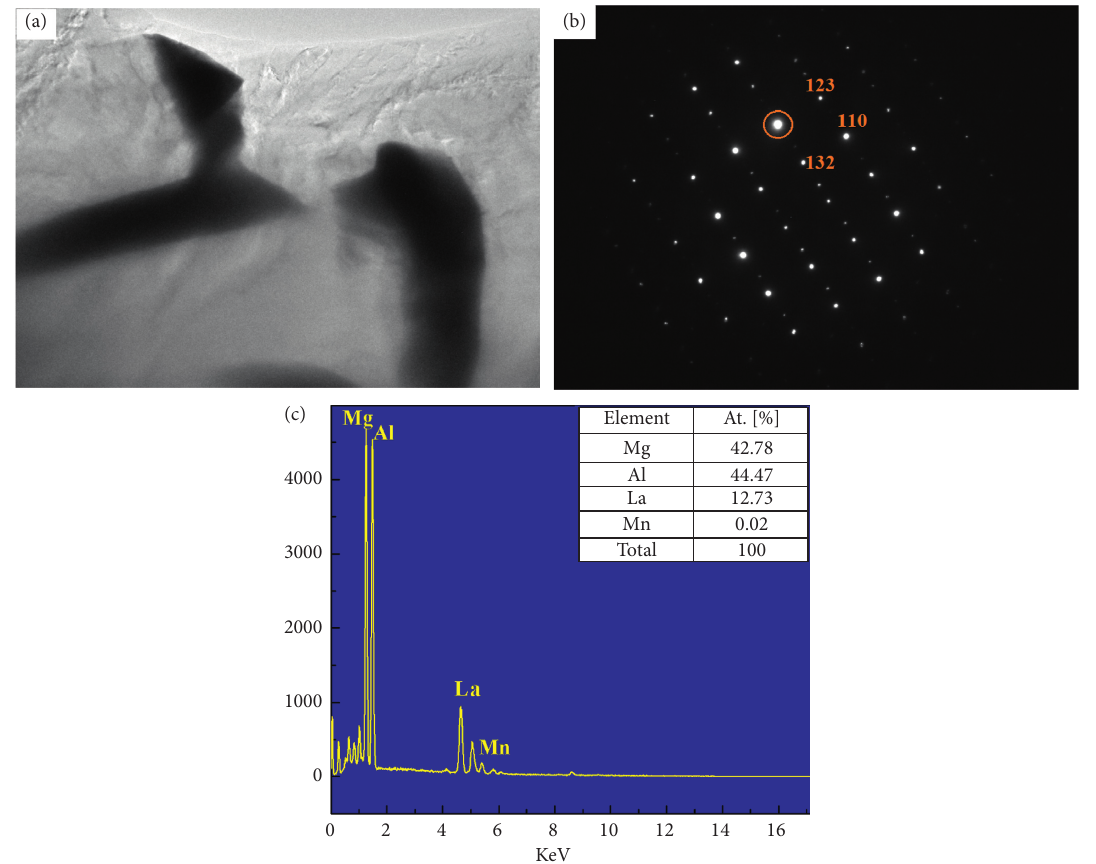
Figure 6: TEM test of broken Al 11 La 3 stubs in the as-extruded AZ80-0.3La alloy: (a) TEM image; (b) the corresponding SAD patterns; and (c) the EDS